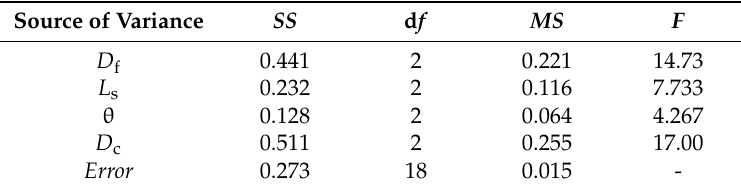
Table 3. Results of variance analysis.